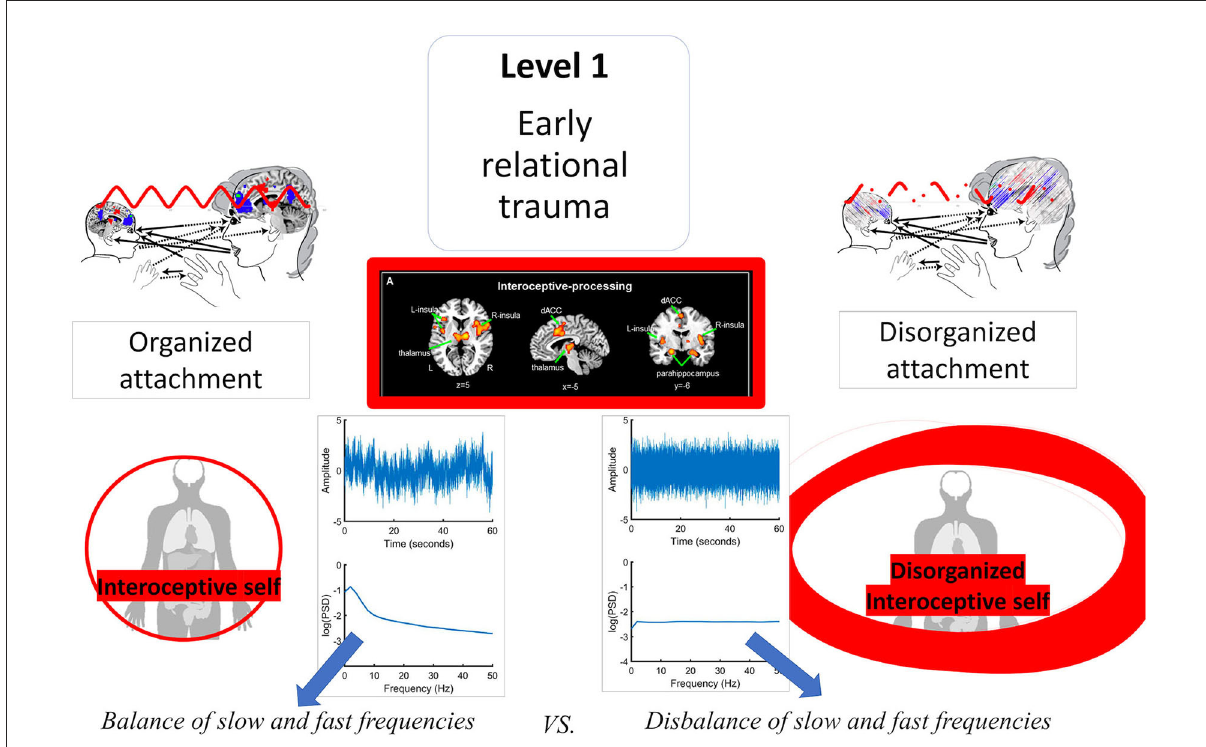
FIGURE6 Visual representation di disorganized interoceptive self